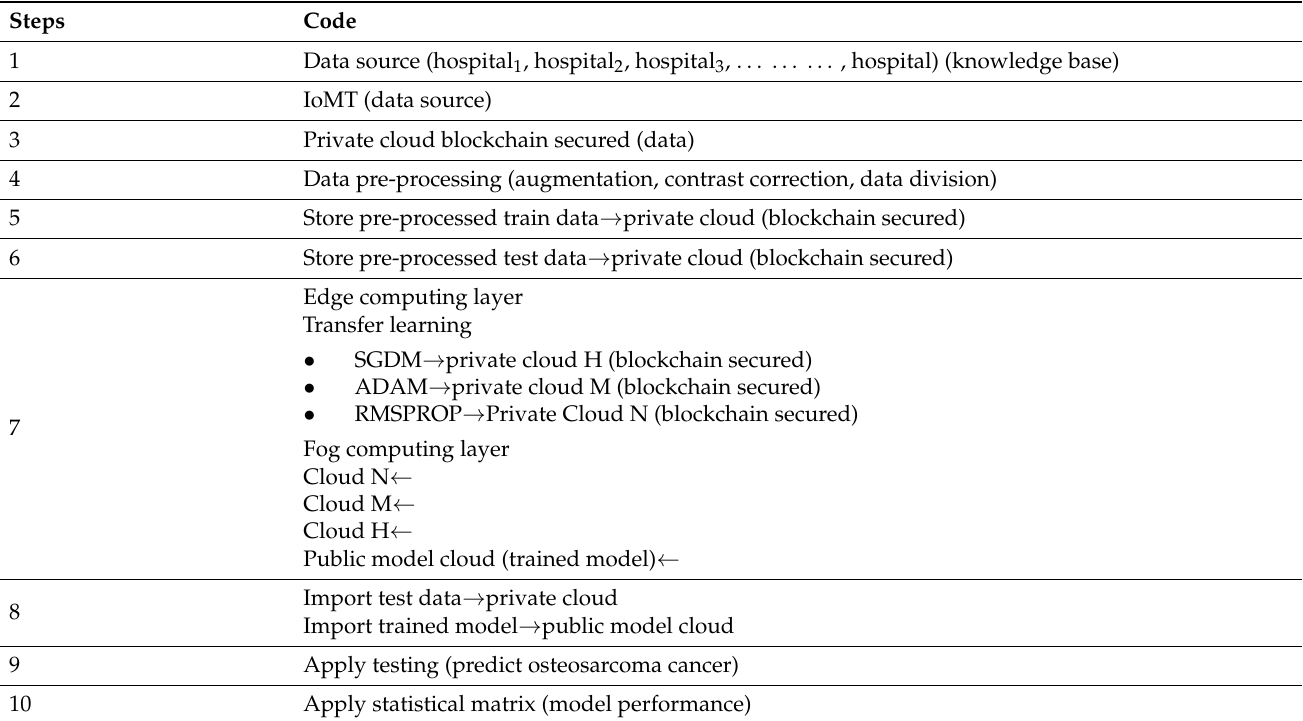
Table 1. Pseudocode for the suggested model for osteosarcoma cancer prediction utilizing transfer learning and IoMT with blockchain security, edge computing, and fog